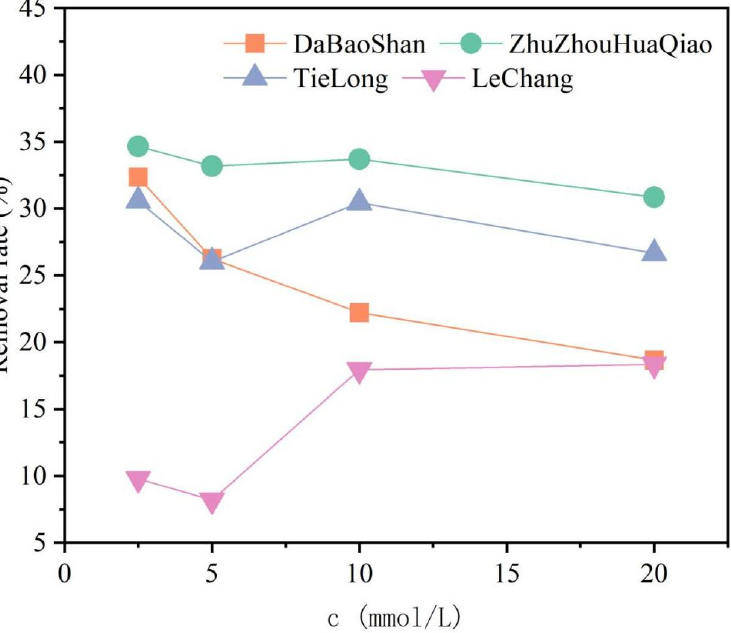
Figure 5. The leaching removal rate of Pb varies with the concentration of GLDA-Na with a pH of 11.13 after 120 min.